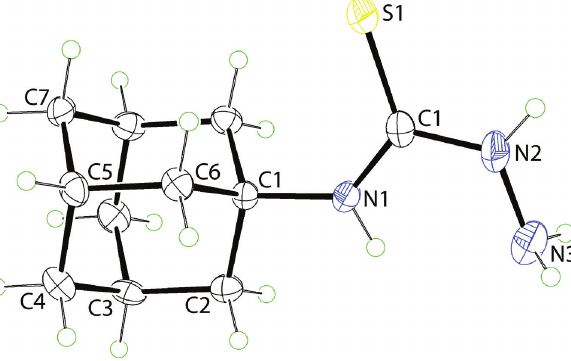
Table 1: Data collection and handling.